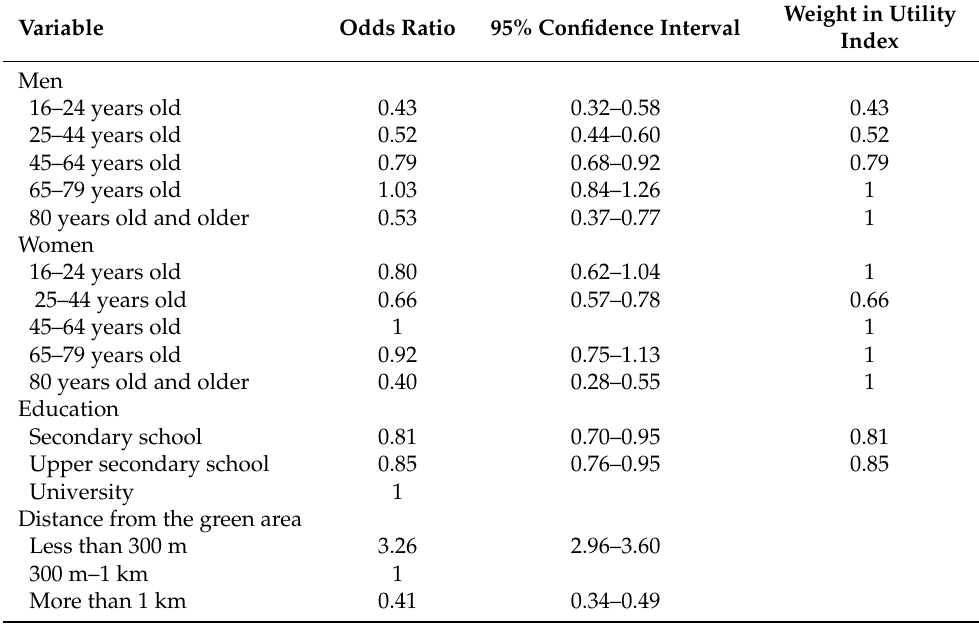
Table 1. Odds ratios for an individual to visit a green area at least once a week. Variable Odds Ratio 95% Confidence Interval